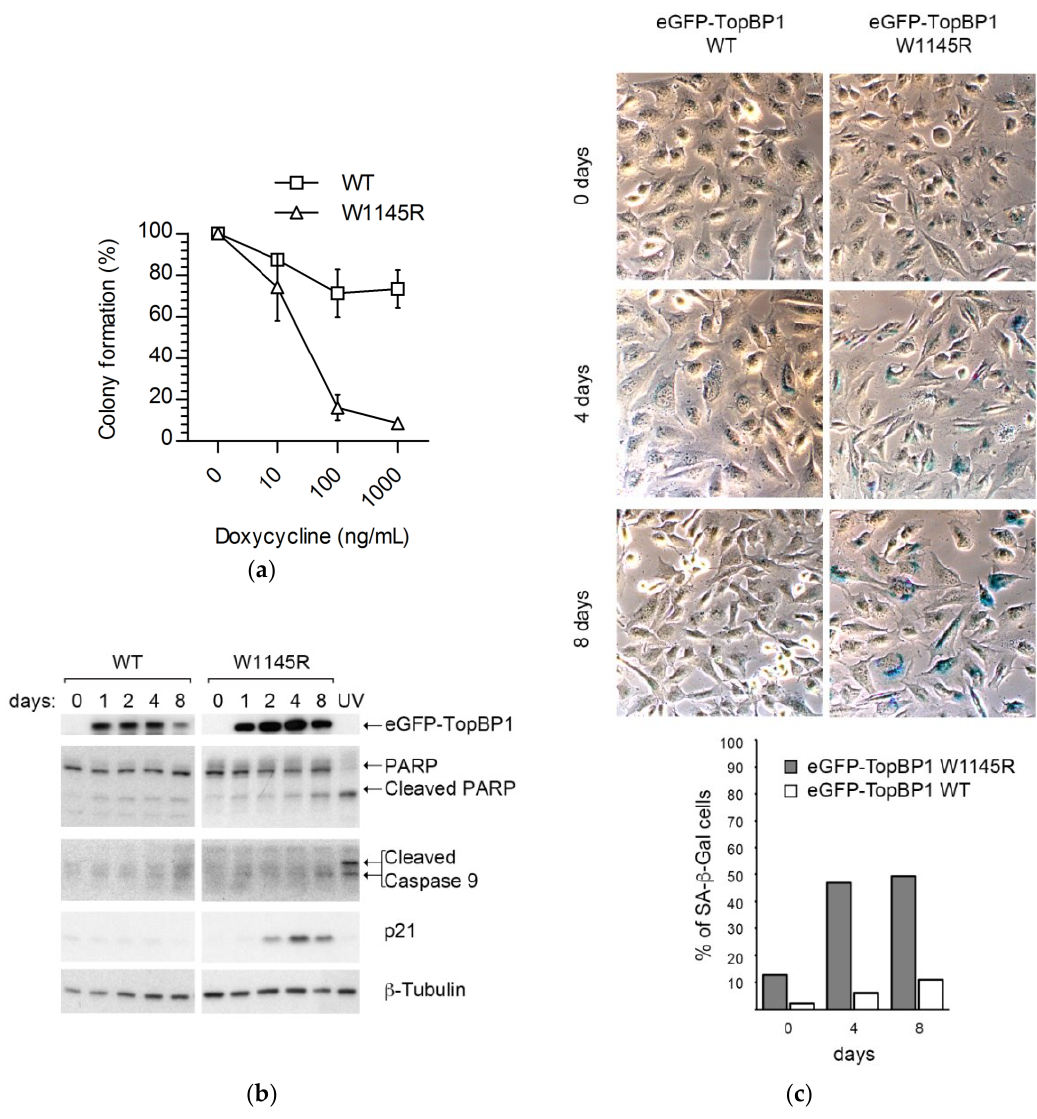
Figure 2. Cells expressing eGFP-TopBP1 W1145R undergo growth arrest and subsequent entry into senescence. ( a ) Colony formation assay of cells expressing eGFP-TopBP1 WT or W1145R. Means of three independent experiments are shown with standard deviations; ( b ) Analysis of apoptotic markers. Whole-cell extracts of cells induced to express either eGFP-TopBP1 W1145R or eGFP-TopBP1 WT for the indicated days were subjected to immunoblot analysis. Non-induced cells treated with 60 J m −2 ultraviolet C (254 nm; UV-C) served as a positive control for apoptotic cells (UV); ( c ) The same cells as in panel B were stained for senescence-associated β-galactosidase (SA-β-Gal) activity. At least 170 cells were counted, and the percentage of SA-β-Gal positive cells were scored (bottom panel).